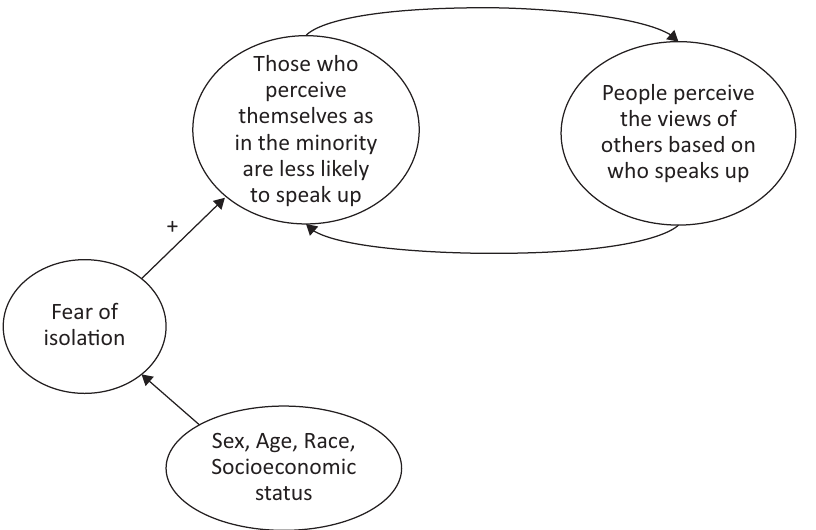
Figure 1. Representation of the spiral of silence theory as a positive feedback loop: Unless the fear of isolation is low, a group will enter a positive feedback loop, where those holding minority opinions are less and less likely to share